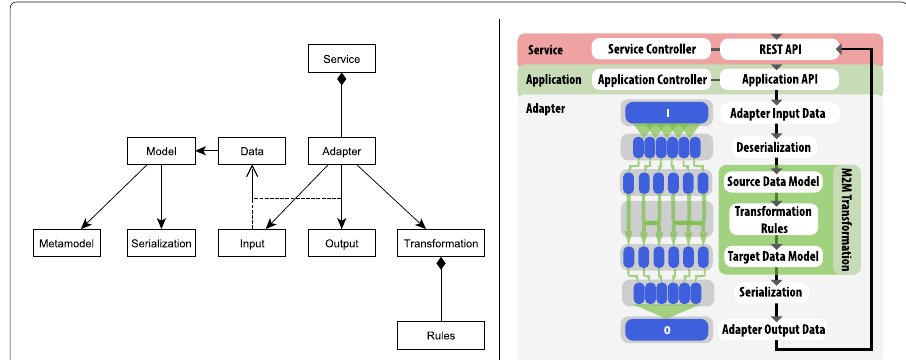
Fig. 2 Left: Representation of implementation model of an adapter. Right: Workflow of an adapter